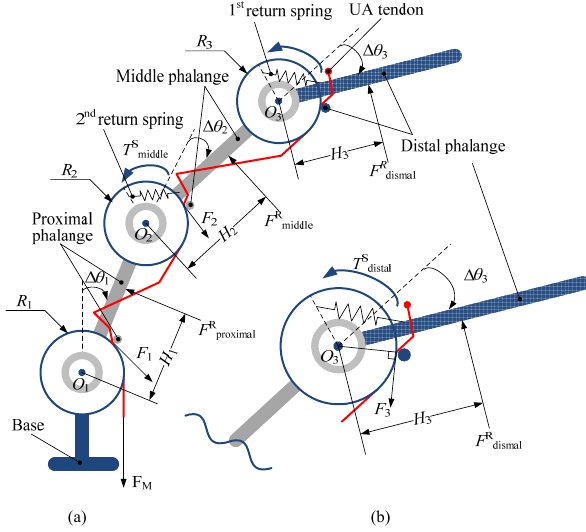
Figure 5. Force analysis of GCUA-T finger when UA motion pro- ceeds. (a) Force analysis on the whole finger; (b) Force analysis on Fig. 5 Force analysis of GCUA-T finger when UA motion proceeds. a) Force analysis on the distal whole finger; b) Force analysis on distal phalange.